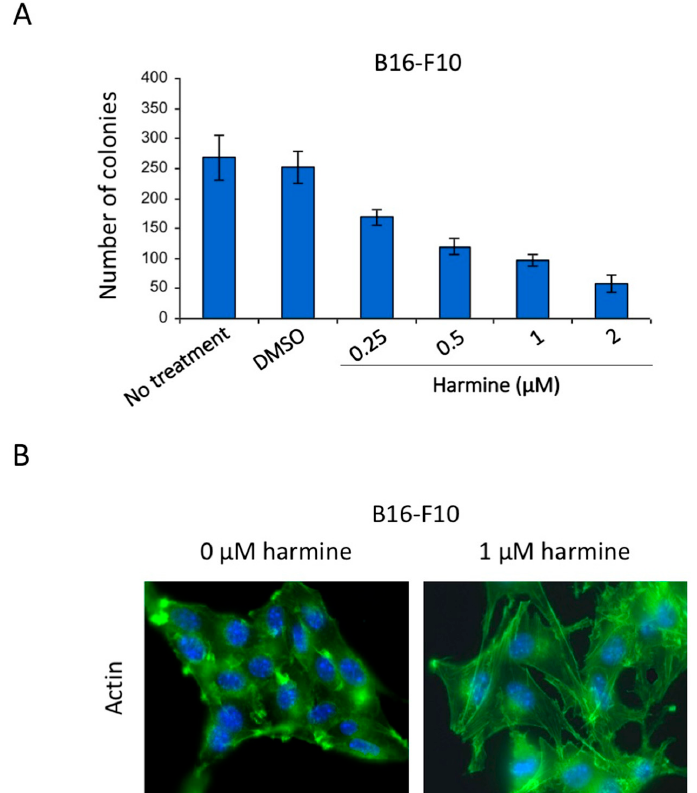
Figure 7. Effect of harmine on B16-F10 melanoma cell anchorage-independent growth, morphology Figure 7. E ff ect of harmine on B16-F10 melanoma cell anchorage-independent growth,